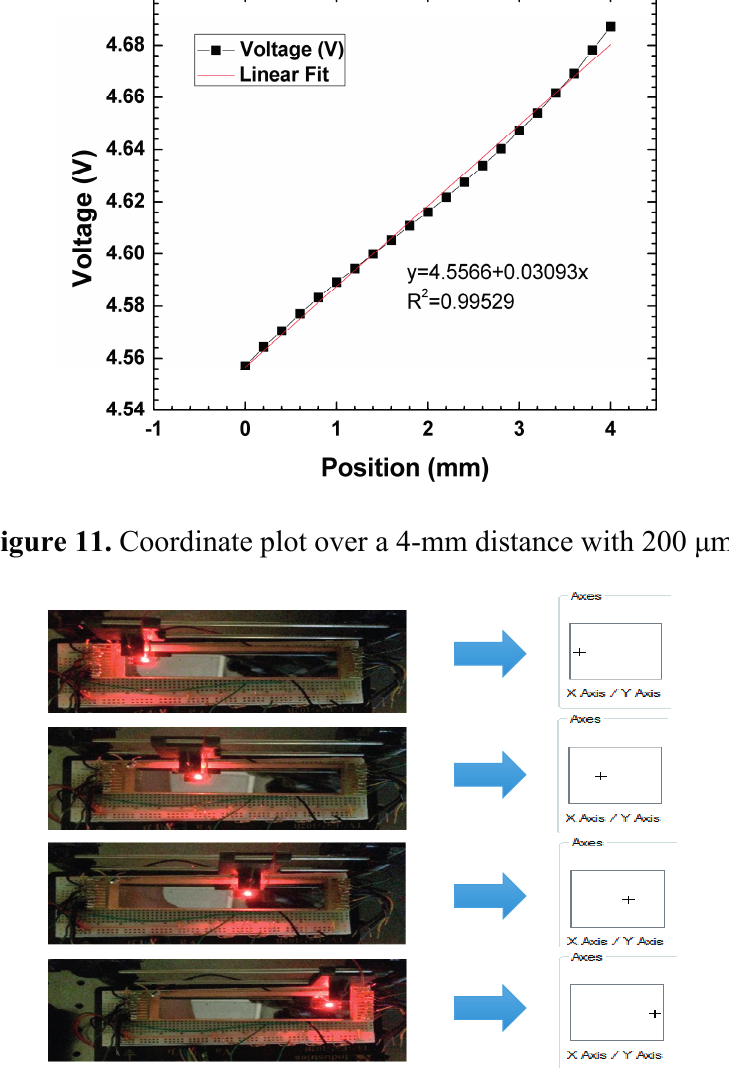
Figure 12. Demonstration of computer interfacing with SBPSD using built-in game controller configuration calibration